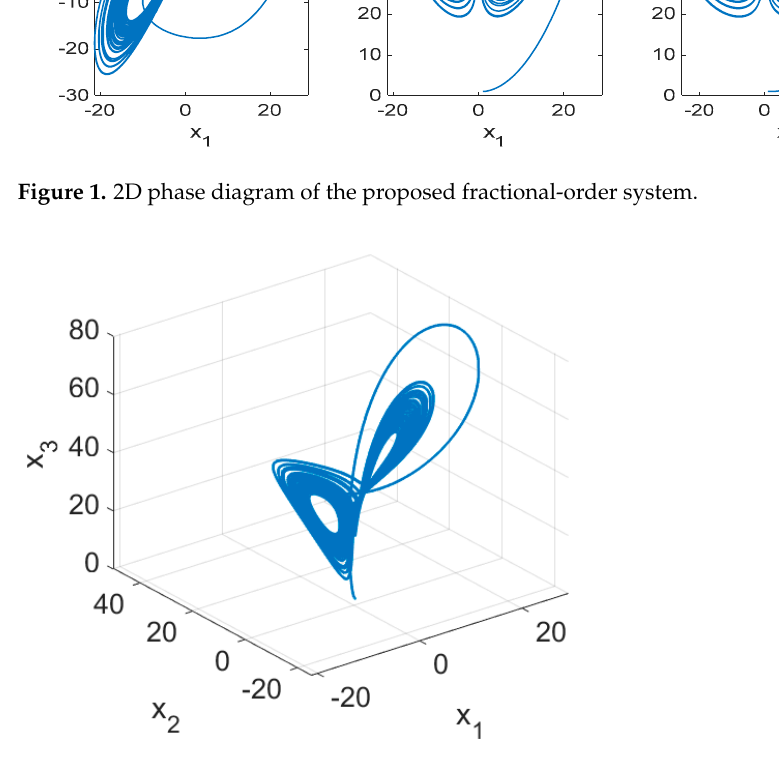
diagram in Figure 4. Figure 3. Lyapunov exponents of proposed fractional-order system.